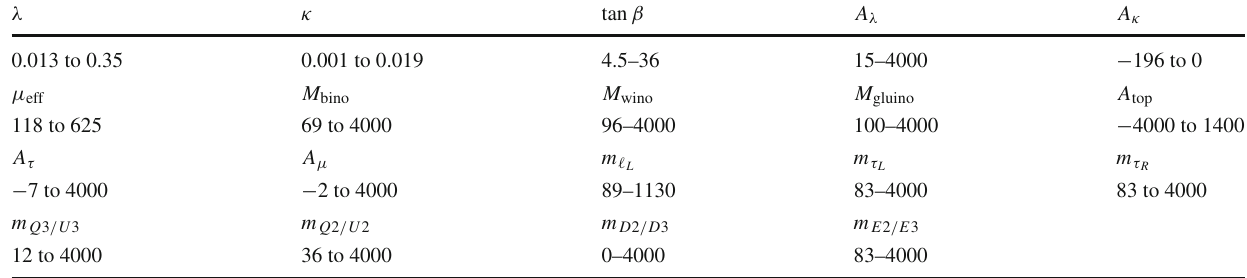
Fig. 1 Direct detection cross section σ SI p as function of the mass of the LSP χ 0